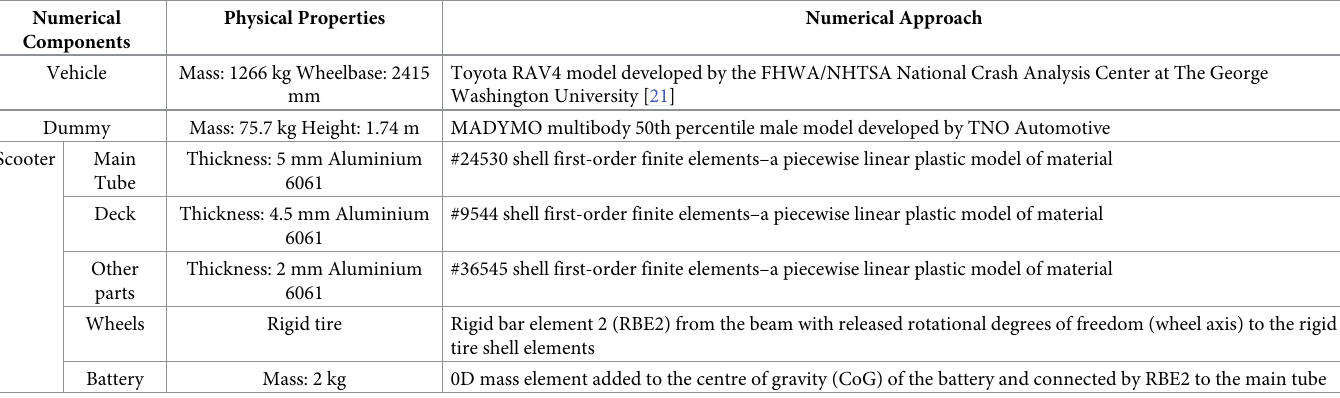
Table 3. The numerical components, their physical properties and applied numerical approach for the study. Numerical